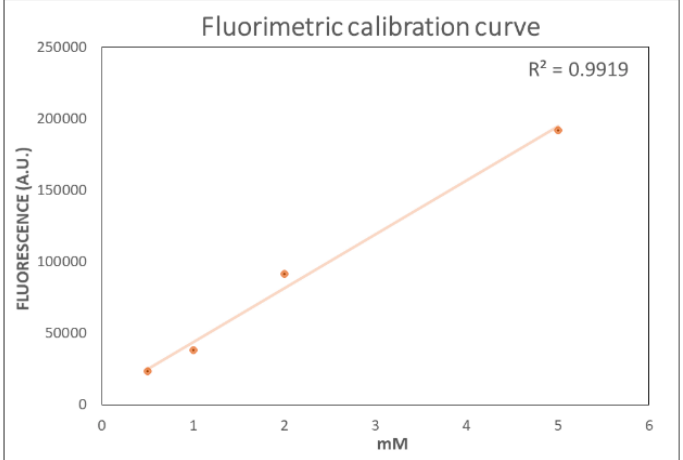
Figure 2. Direct fluorometric method calibration curve in the range 0.5–5 mM.